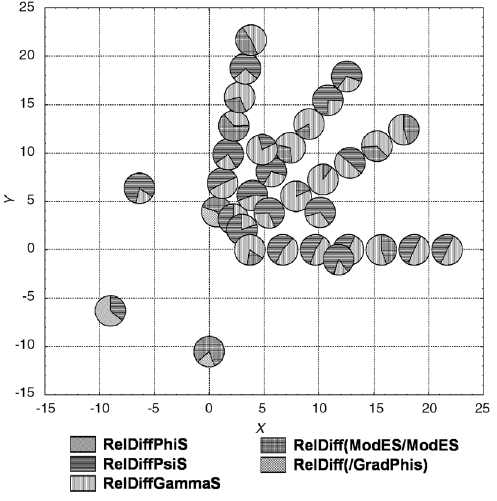
Fig. 10. Calibration of the proposed nine-electrode measuring array centered at the point (0, 0) by using point source placed at the point ( x , y ). The circular diagram at each given point of the tablet shows the relation between the signal components of measuring array produced by a point source located at this point (see